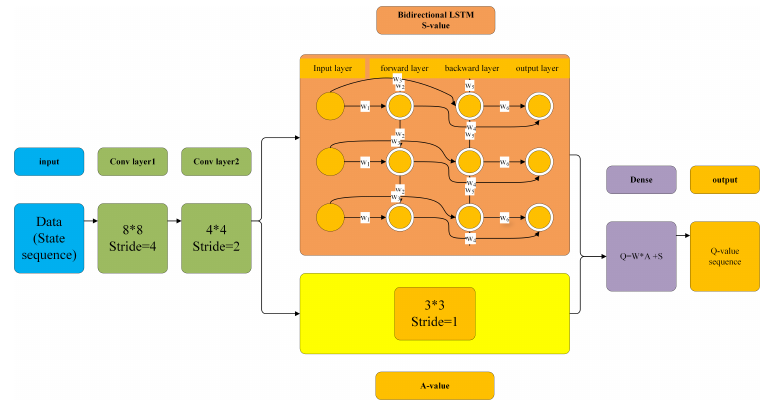
Figure 3. Proposed D3RQN structure with bidirectional